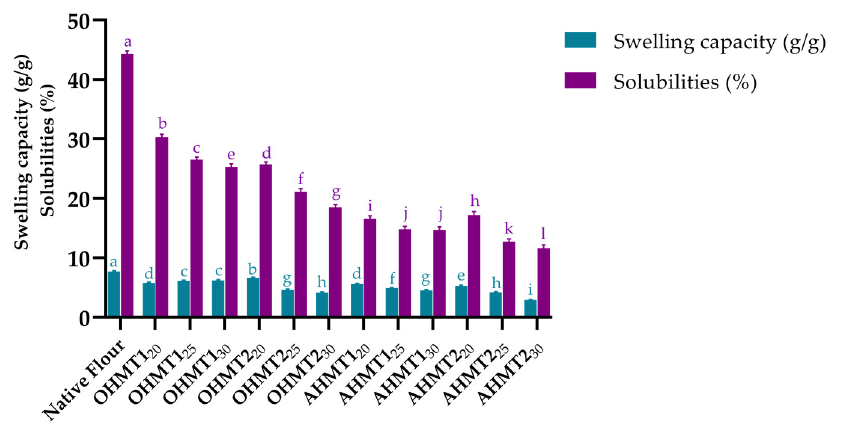
Figure 1. The swelling capacities and solubilities of native and HMT-treated purple rice fl our sam- Means ± standard deviations from three replicate experiments. Different letters in the same column ples. Means ± standard deviations from three replicate experiments. Di ff erent le tt ers in the same are considered significantly different according to Duncan’s multiple comparison test ( p < column are considered signi fi cantly di ff erent according to Duncan’s multiple comparison test ( p ˂ 0.05).